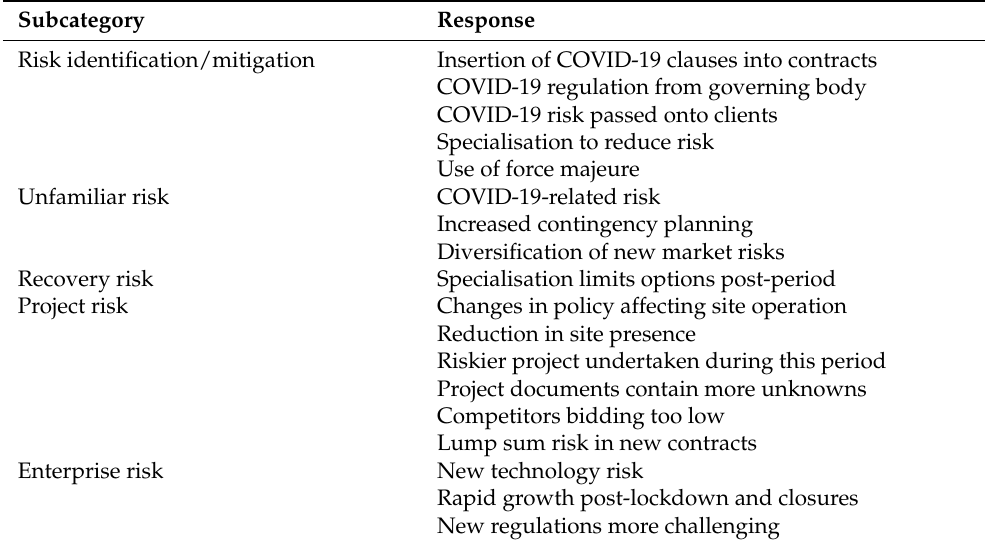
Table 5. Risk-management-related